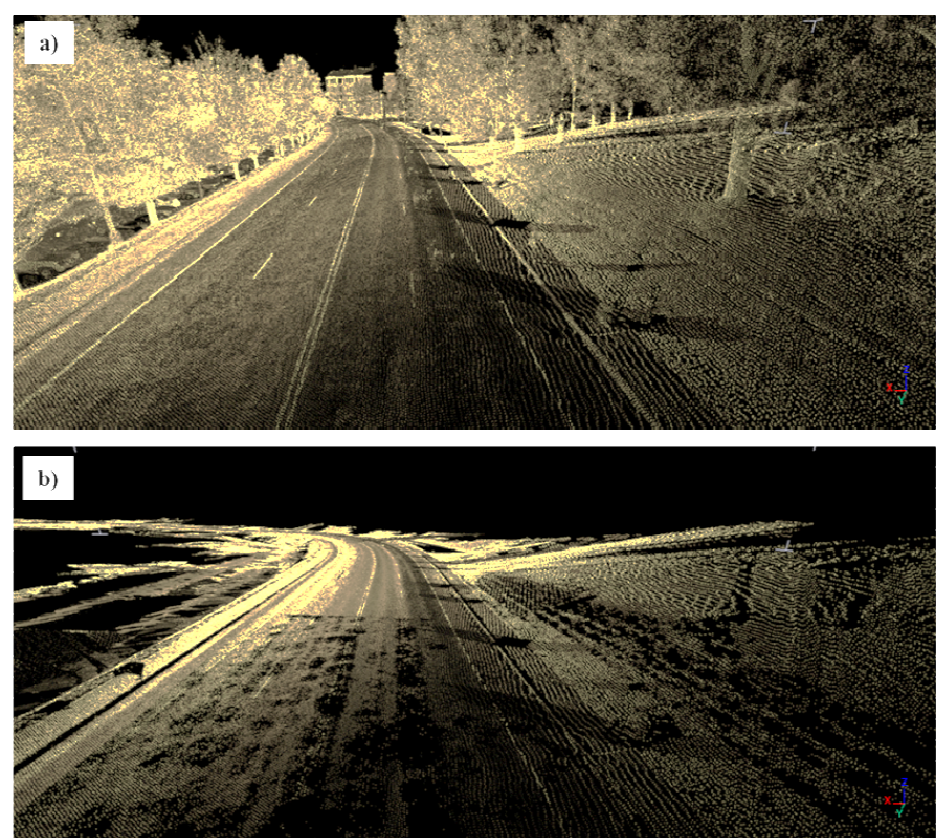
Figure 3. A visual comparison between ( a ) the all-return co-registered ground-based point cloud and ( b ) the co-registered ground-based bare-earth classified point